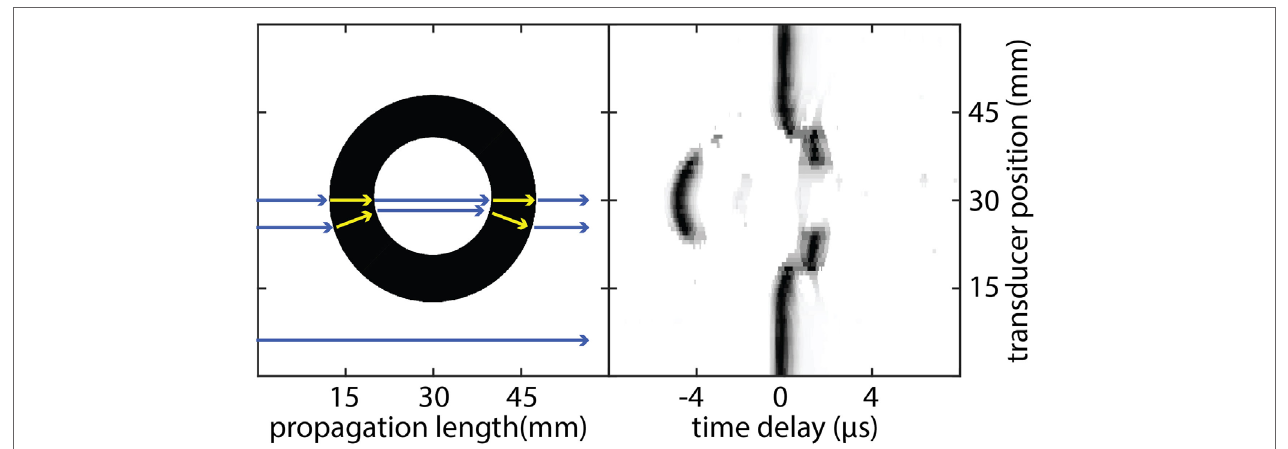
FigUre 3 | Schematic representation of ultrasound propagation through a hollow 35 mm diameter Perspex cylinder (left) and the resulting ultrasound signal amplitude detected at the receiving transducer as a function of time (right). As each wave propagates from the transmitting transducer, it experiences different propagation speeds when it travels through different media. Each wave can also experience different path lengths if there is significant refraction occurring. The combination of both effects results in a time delay registered at the receiving transducer compared with propagation through water alone. Each transducer element signal is normalized to the maximum value separately for